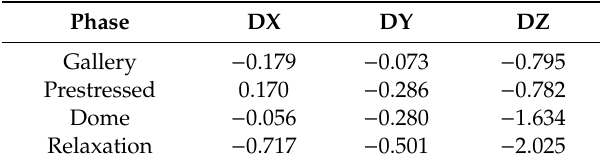
Table 20. Displacement of the connecting rod support (mm) (Figure 13a).